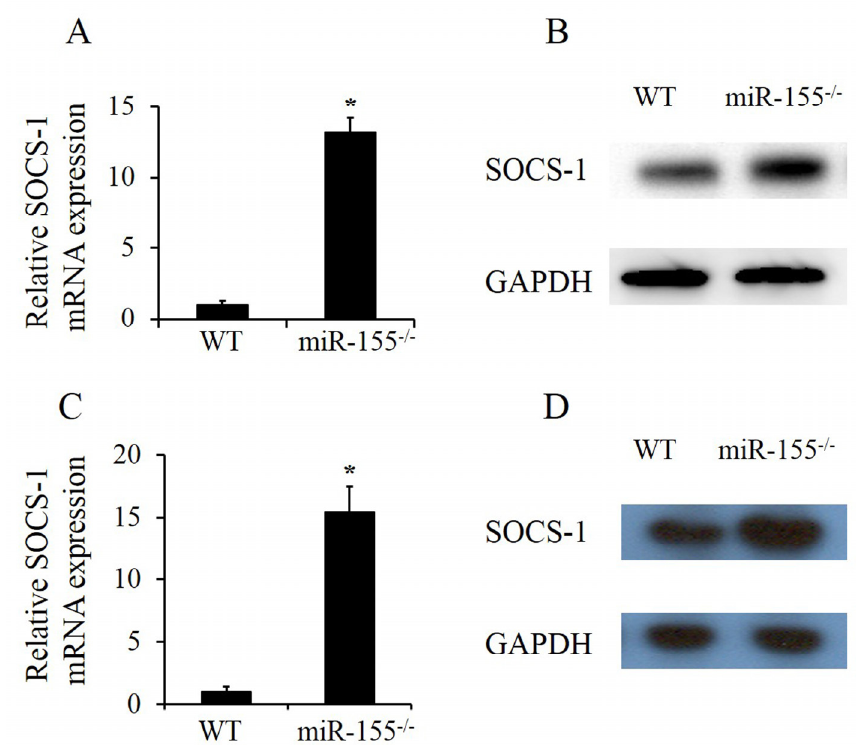
Figure 4. MiR-155 suppressed suppressor of cytokine signaling 1 (SOCS-1) in lung tissues and neutrophils. ( A , B ) MiR-155 – / – mice were smoke-exposed for 15 min and sacrificed after 12 h, following which SOCS-1 mRNA and protein level of whole lung homogenates were measured. Neutrophils were isolated from lung tissues after 12 h following smoke exposure, and isolated neutrophils were treated with smoke for 30 min. ( C , D ) After 24 h of culture, SOCS-1 mRNA and protein level of isolated neutrophils were analyzed. n = 4 mice per group. * p < 0.05 vs. WT mice treated with smoke.